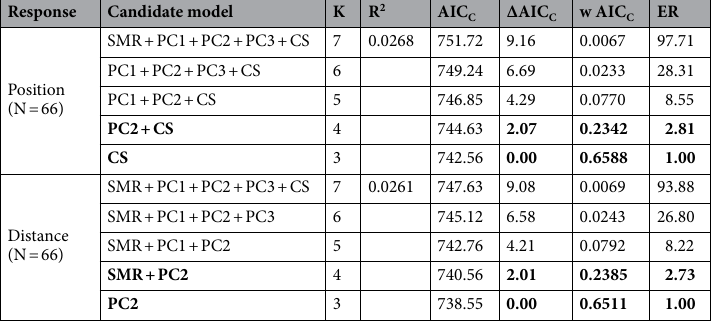
Table 2. Comparison of AIC C deltas and weights for general linear models testing the effects of metabolic rate (SMR), initial body size (centroid size, CS) and initial shape (PC1, PC2) on secondary dispersal (maximum distance from the release point) and settlement positions of juvenile brown trout along the stream axis after day 60. Shown are the number of parameters (K), the resulting AIC C , the ΔAIC C , AIC C weight and the evidence ratios (ER). The best model and models roughly equivalent to the best (ΔAIC C ≈ 2 or lower) are highlighted in